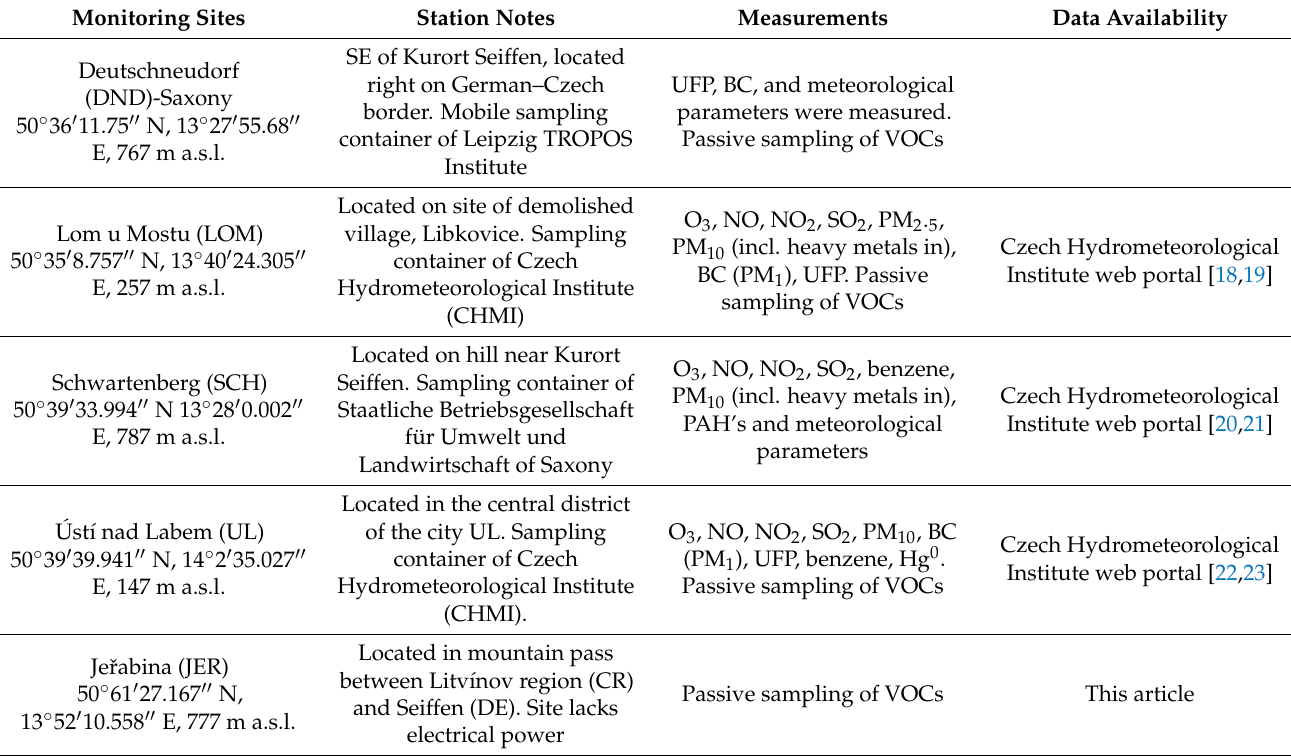
Table 1. Monitoring sites, station notes, measurements made, and availability of